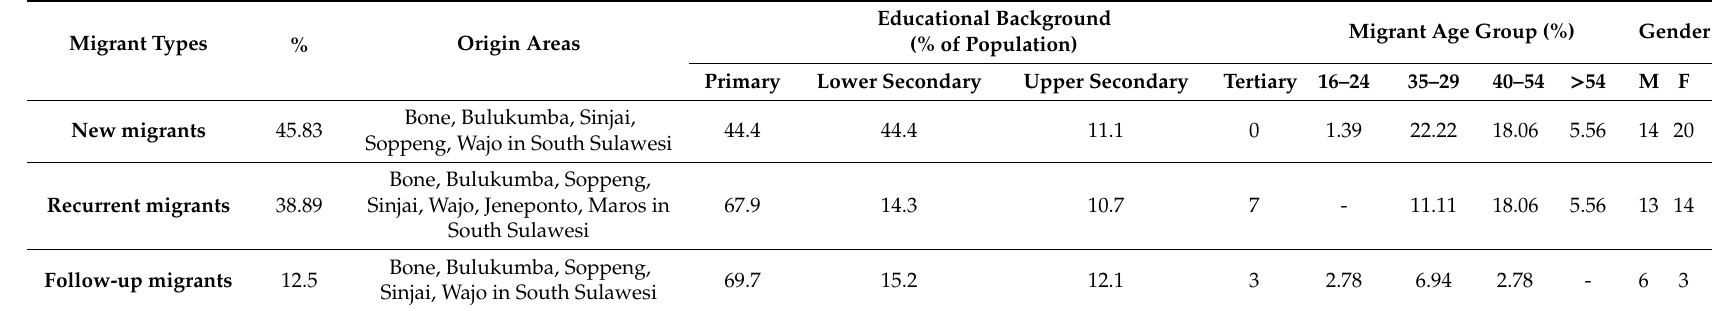
Table 2. Migrant types and characteristics in Southeast Sulawesi